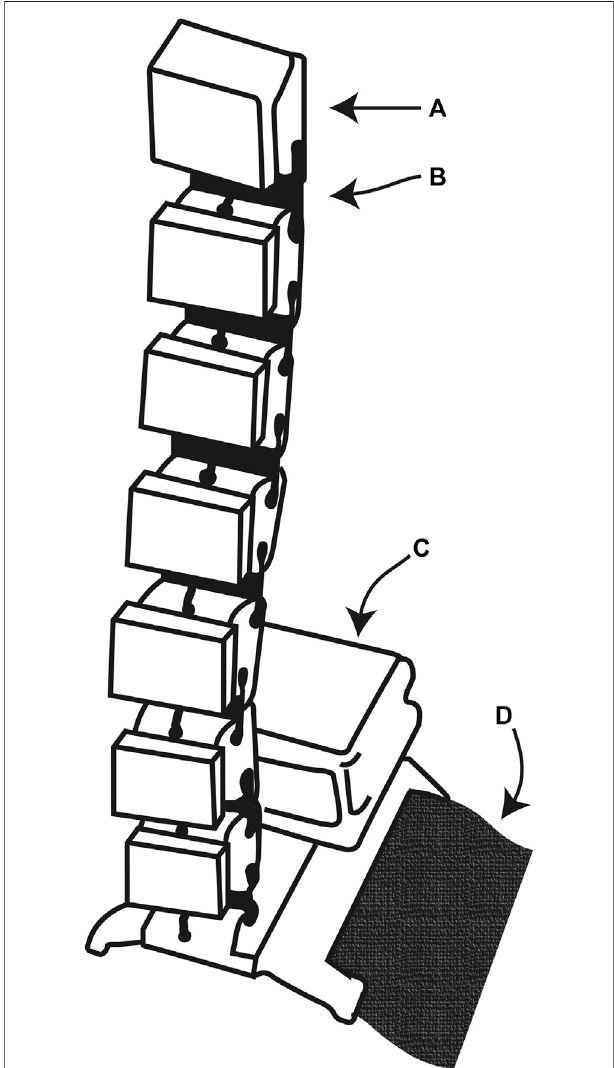
FIGURE 2 | The Robotic sixth fi nger. (A) 3D-printed rigid link. (B) 3D- printed fl exible link. (C) Dynamixel MX-28 servomotor. (D) Velcro strip mounted on the rigid 3D-printed